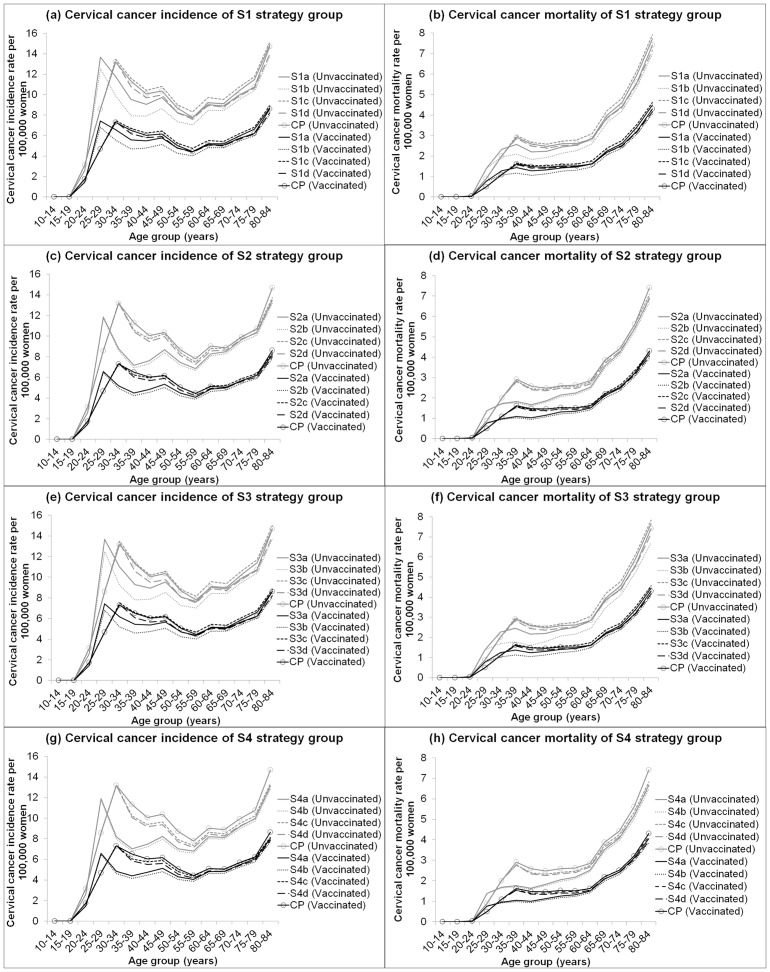
Estimated age-specific of cervical cancer incidence rate and cervical cancer mortality rate for all strategies.